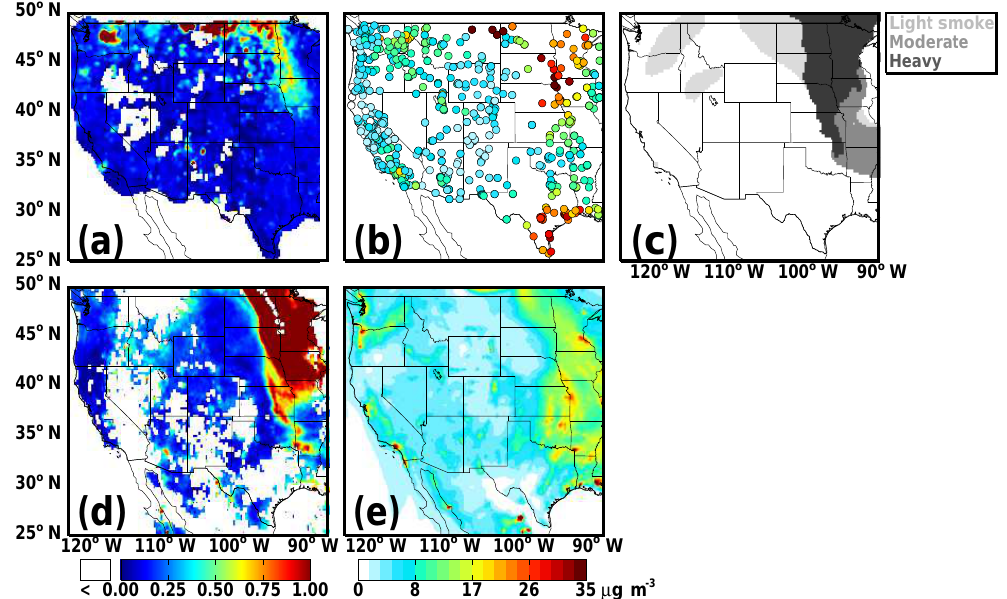
Figure 1. Example datasets for 29 June 2015. (a) Population-weighted (Eq. 1) percent of Facebook posters meeting the criterion (white signifies regions with weighted population <10), (b) 24h average surface PM 2 . 5 concentrations from surface measurement sites, (c) gridded HMS smoke product, (d) gridded, unfiltered MODIS Aqua and MODIS Terra AOD (white signifies no valid observation), and (e) WRF- Chem-simulated 24h average surface PM 2 . 5